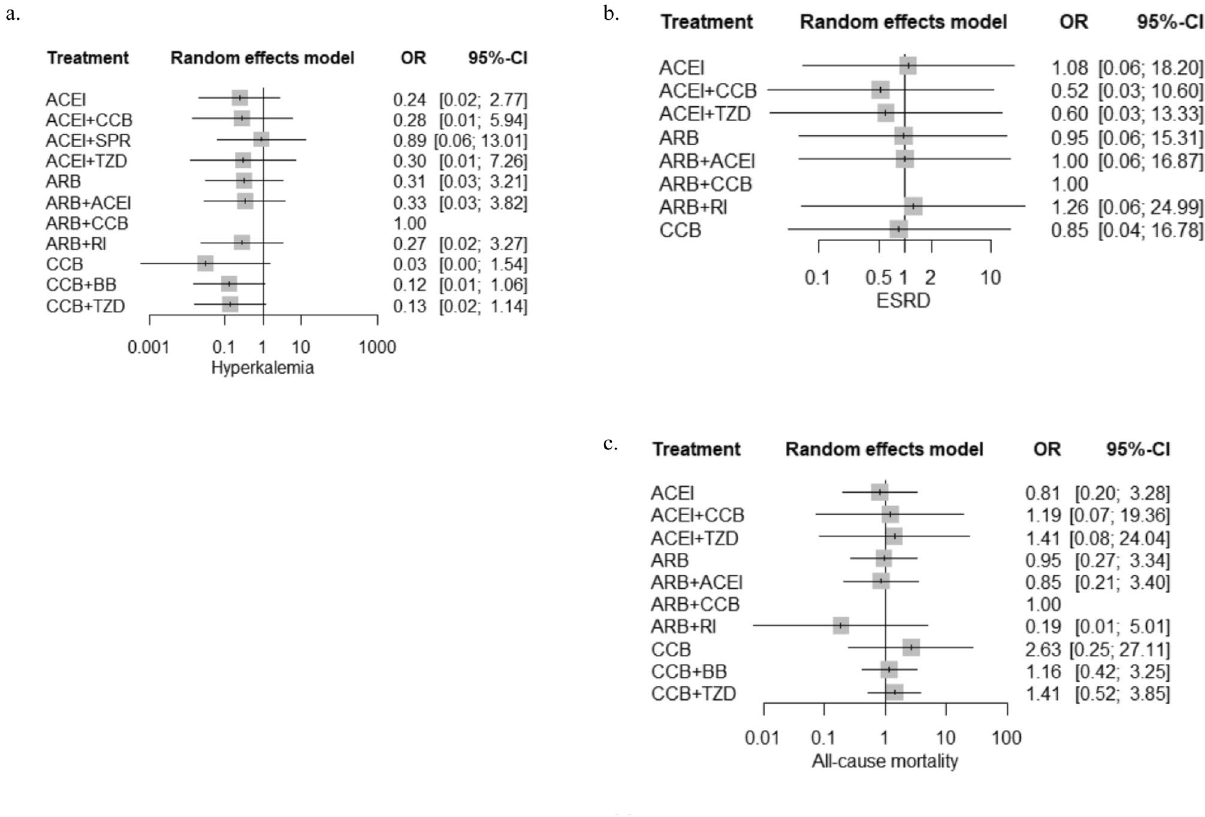
Figure 5. Other clinical outcomes of antihypertensive interventions in CKD patients. ( a ) Hyperkalemia, ( b ) ESRD progression, and ( c ) all-cause mortality.